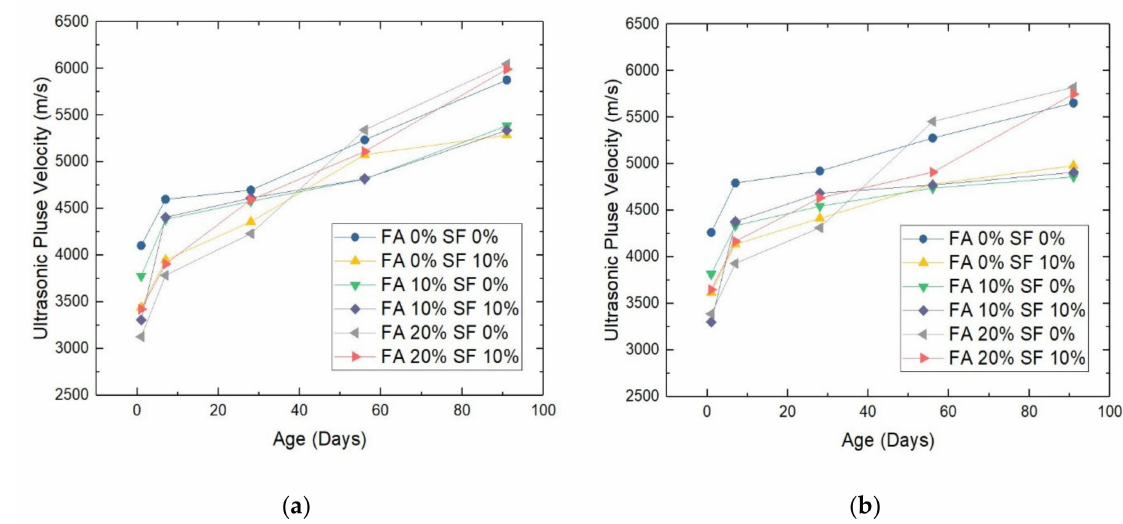
Figure 7. The ultrasound pulse velocity of HPC samples with a water/binder (W/B) ratio of ( a ) 0.28 or ( b ) 0.30. Note: FA = fly ash; SF = silica